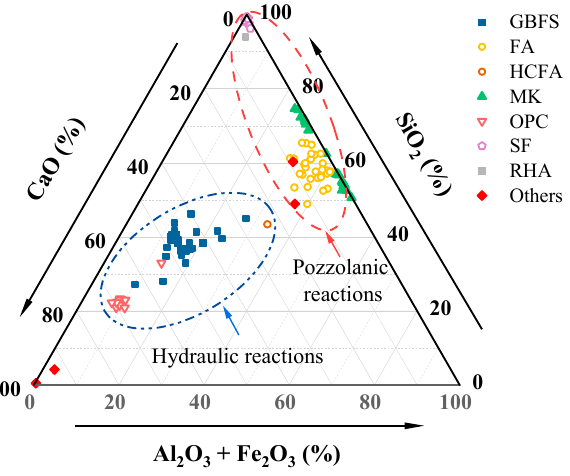
Figure 4. Ternary diagram of the main precursor.